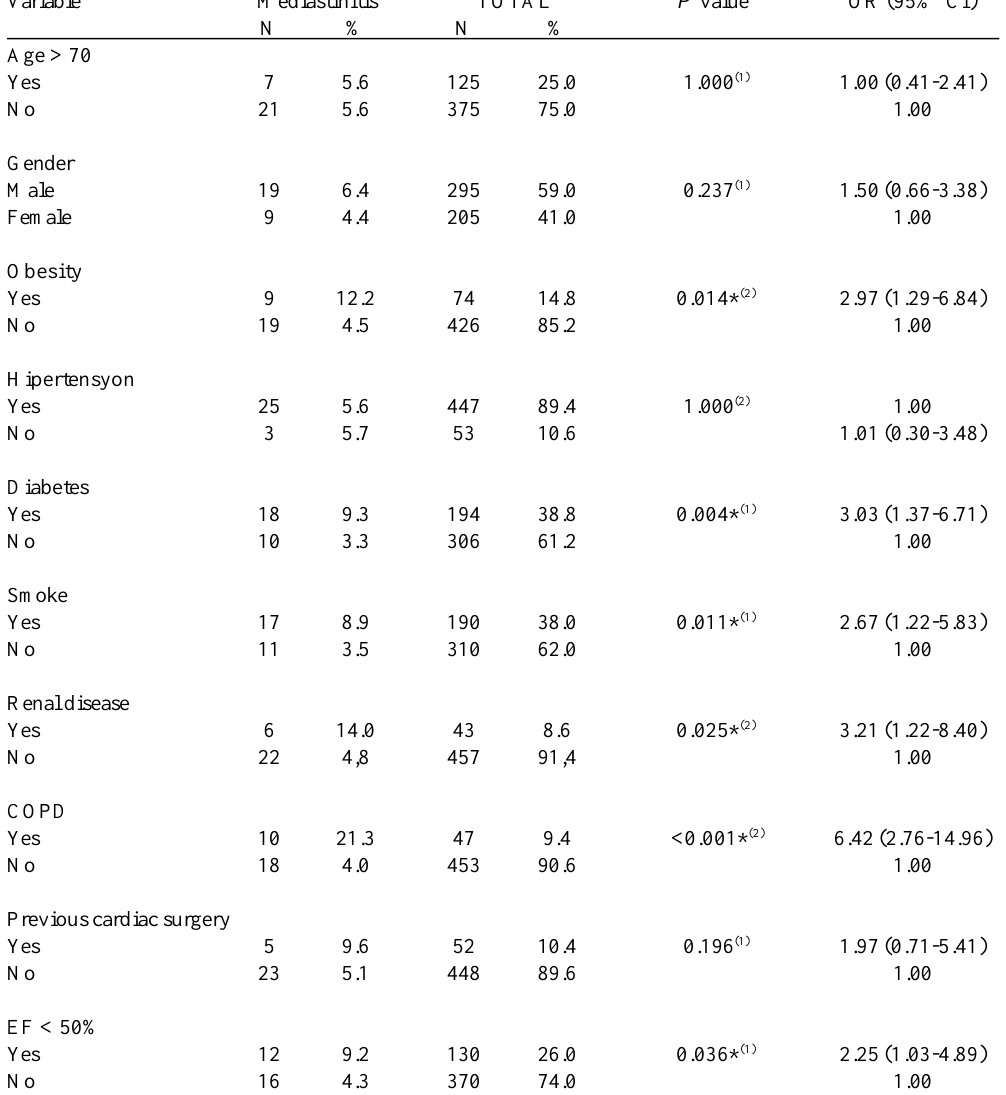
Table 1. Incidence of mediastinitis according to preoperative variables (univariate